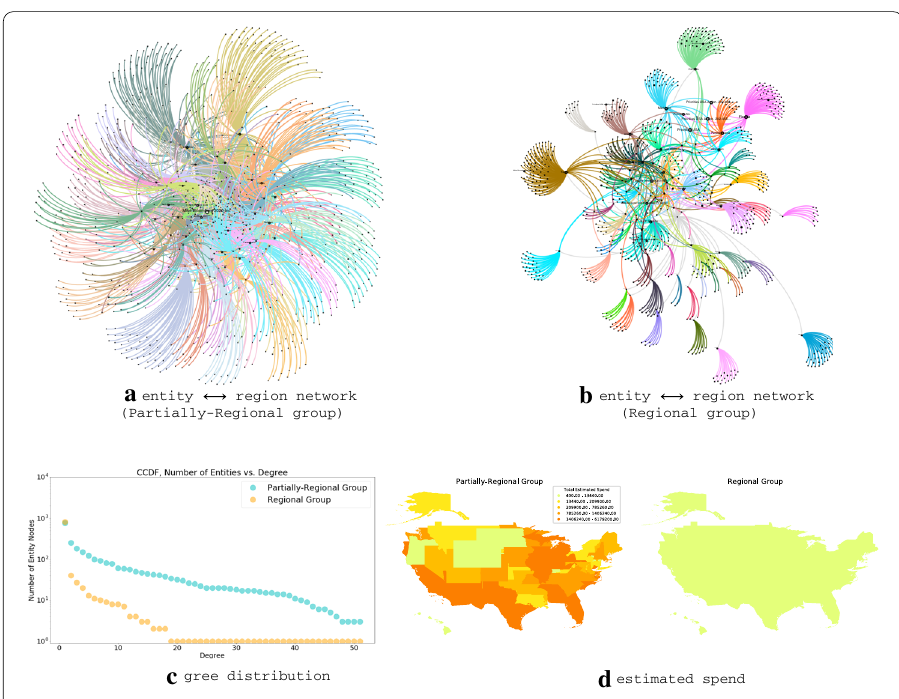
Fig. 8 a , b Bipartite networks of funding entities connected to regions their ads dominate for the Partially-Regional group ( a ) and the Regional group ( b ). Region nodes are uniquely colored, whereas entity nodes are grey. Entity nodes are larger if they spend more in the network, and region nodes are larger if more was spent on them in the network. High-spending entity nodes are labeled with their “disclaimer” component. The weight and label of an edge from entity E to region R reflects E ′ s total spend on ads dominated by R . Both networks were visualized in Gephi (Bastian et al. 2009) using the same layout algorithm (Hu 2005) and same parameters (colors, size, spline, etc). c Degree distribution showing, for a given x value, the number of entities in each network with degree at least x. d Estimated total spend on regionally-dominated ads per region, separated by partition group. The total is obtained by summing the lower bound of each relevant ad’s estimated spend bin. The Regional group’s map (right) is completely yellow, indicating the lowest level of spending in each region; in contrast, the Partially-Regional group’s map (left) shows very little